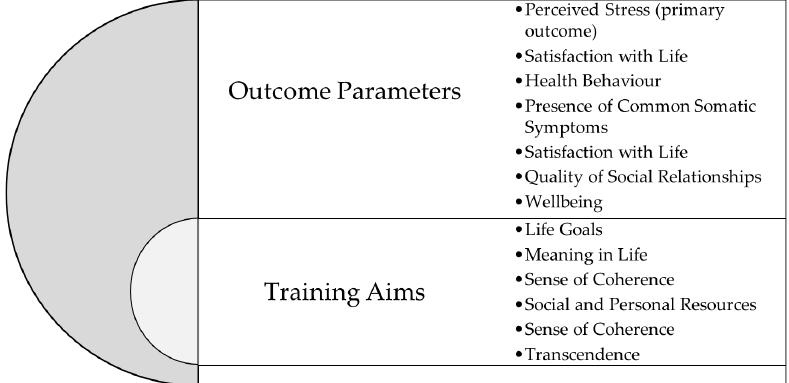
Figure 2. Training aims of the intervention and outcome parameters in this study.